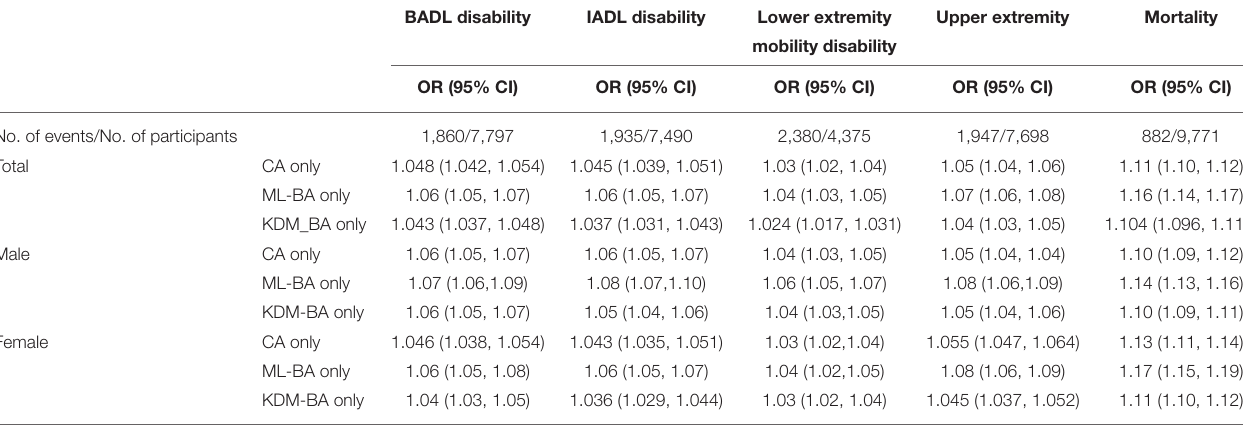
TABLE 3 | Unadjusted associations of CA, ML-BA, or KDM-BA with disability and mortality in the full sample and sex subgroup. BADL disability IADL disability Lower extremity Upper extremity Mortality mobility disability OR (95% CI) OR (95% CI) OR (95% CI) OR (95% CI) OR (95%